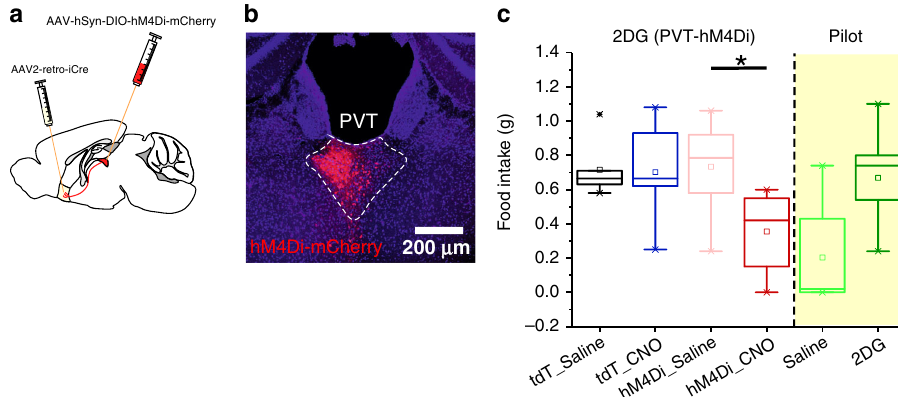
Fig. 8 pPVT – NAc neuron activity is required for glucoprivation-induced feeding behavior. a Schematic of the stereotaxic injections for selective expression of the hM4Di-mCherry and control viral vectors in pPVT – NAc neurons. b Representative image of hM4Di-mCherry expression in pPVT – NAc